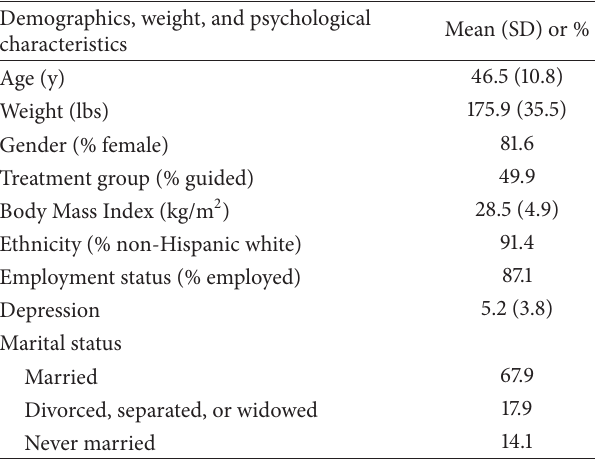
Table 1: Baseline demographic and psychological data for entire study